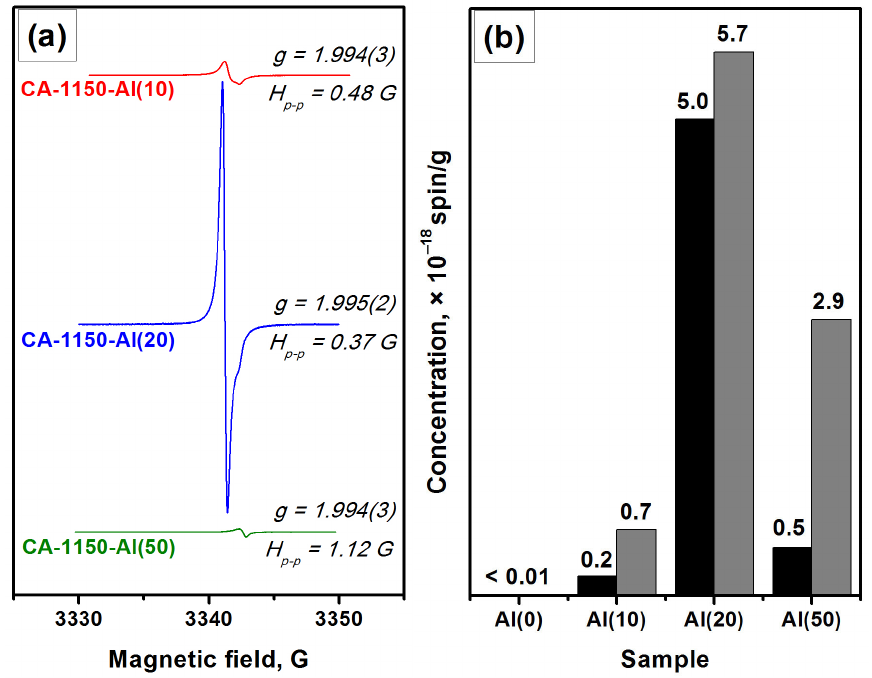
Figure 3. EPR spectra for a series of samples calcined at 1150 °C ( a ) and concentration of F + -like centers obtained for these samples ( b ): as-registered (black) and normalized to the content of the mayenite phase (gray).